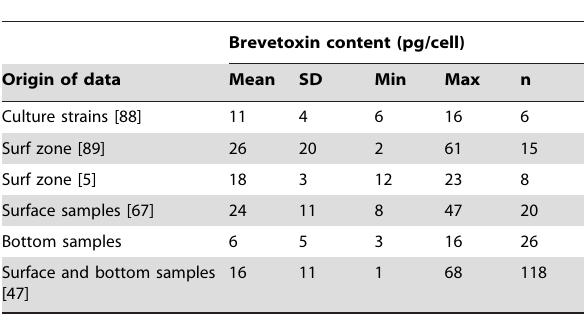
Table 1. Mean values, standard deviations (SD), and ranges (min and max) for total brevetoxins per cell (pg/cell) from various culture and field